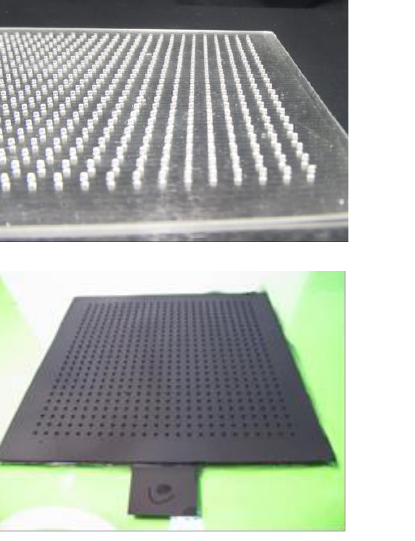
( b ) Figure 9. Scheme of a dielectric elastomer pressure sensor with two knot-shaped profiled outer films with electrode layers and an elastomer film with only one electrode layer covered by two dielectric layers between the profiles in the unloaded state ( a ) and in the loaded state ( b ) [99]. As with the wave-shaped profiles, the three electrode layers approach each other when the sensor is compressed. However, the stretch of the intermediate film causes an increase in the capacitance only in the first phase of the compression until the knots of one profile press the intermediate film against the other profile. In the second phase of the compression, the knots and the intermediate film are squeezed, thereby diminishing the distance between the electrodes, which results in a further enhancement of the capaci- tance. Figure 10a shows two elastomer sheets with knot profiles. The upper one is not cov- ered, and the lower one is covered by an electrode layer. Furthermore, Figure 10b depicts the comparison of the characteristics of pressure sensors with different profile shapes, e.g., wave profiles, bar profiles and knot profiles, where all profiles are covered by electrode layers [100]. The knot profile sensor reaches a smaller final capacitance at the highest pres- sure of 0.1 MPa than the sensor with wave profiles, but the initial capacitance is also lower.